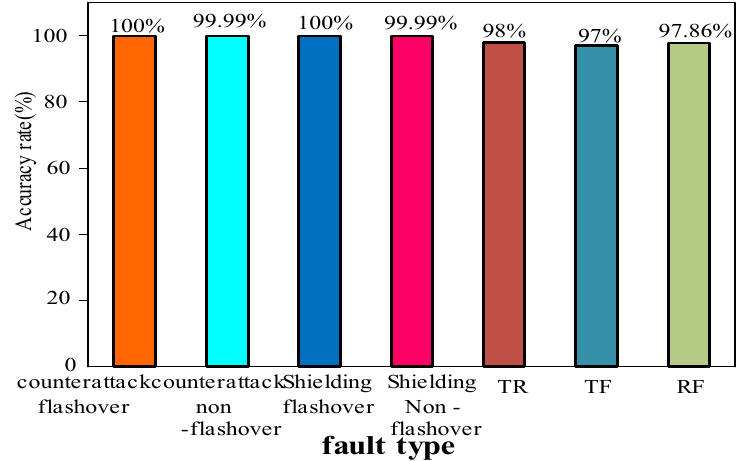
Figure 17. Test accuracy of different fault types.